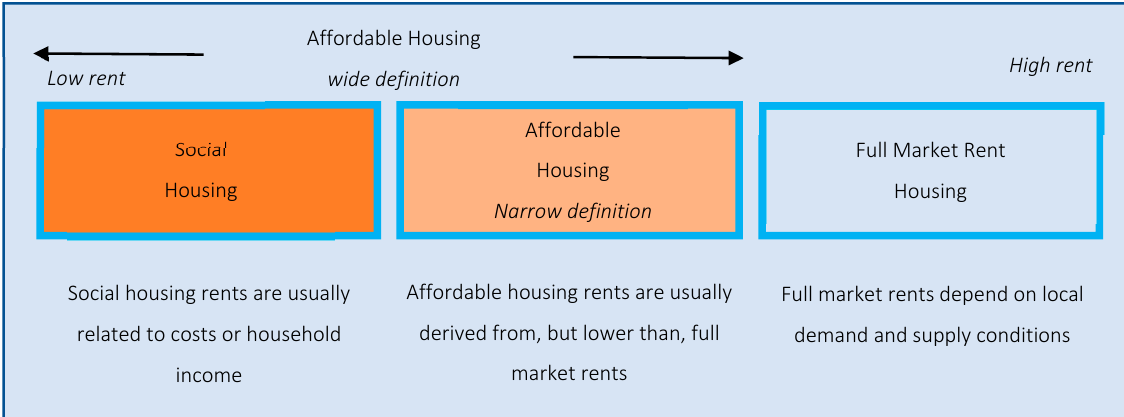
Figure 1. Rental housing segments. Source: [21], adapted by authors.